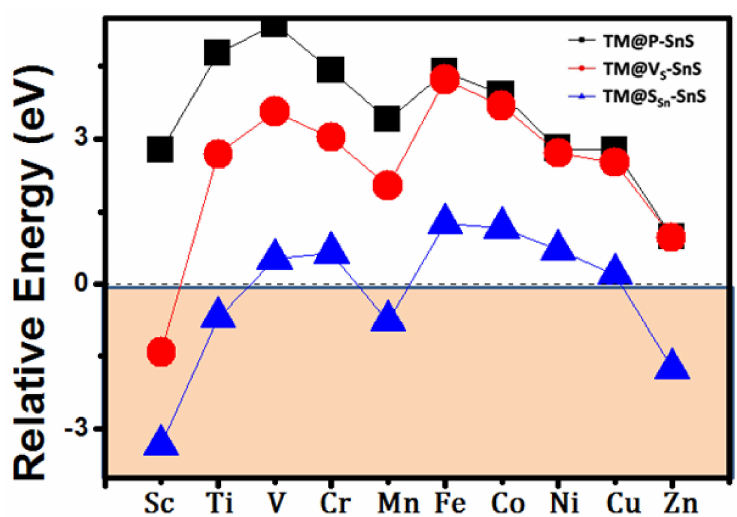
Figure 3. Relative energies of the TM decorated 2D SnS monolayer, which is defined as the energy difference of binding energy of TM on the SnS monolayer and the cohesive energies of TM atoms. A negative value of relative energy indicates that TM atoms will not form a cluster, and the systems are